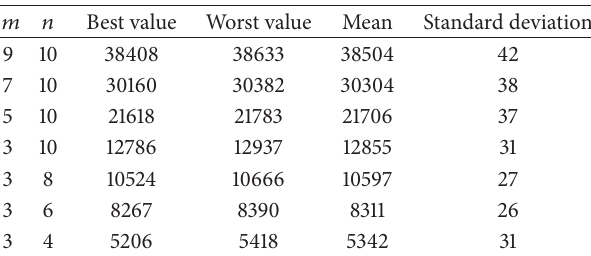
Table 1: Stability analysis of the auto-adapted DE algorithm. 𝑚